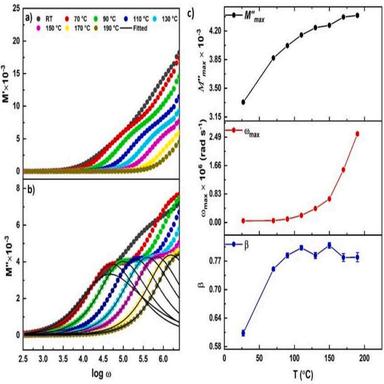
Variation of a) the real part, M′ , b) the imaginary part, M'' of electric modulus with frequency for different temperatures, and c) The variation of extracted parameters (M''max, ωmax, and β) at all temperatures.